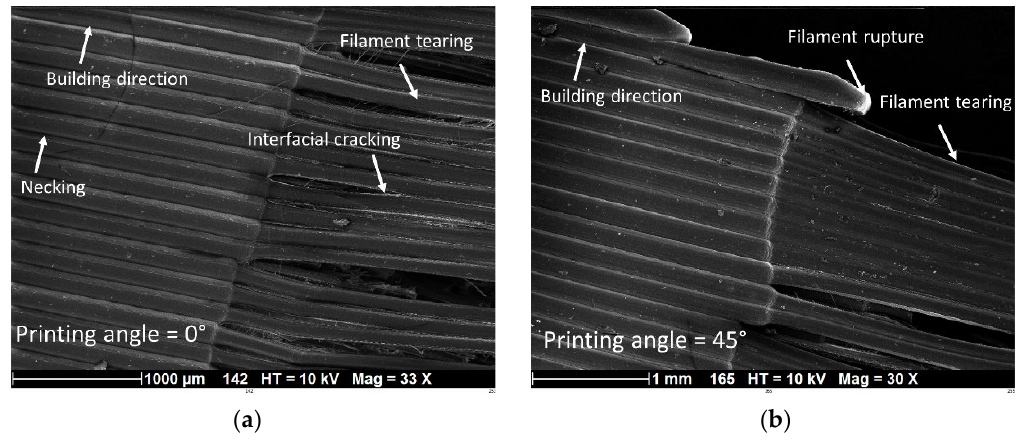
Figure 17. SEM micrographs of fractured surface of 3D-printed PLC according to lateral orientation (LA) with two printing angles: ( a ) 0° and ( b ) 45°.